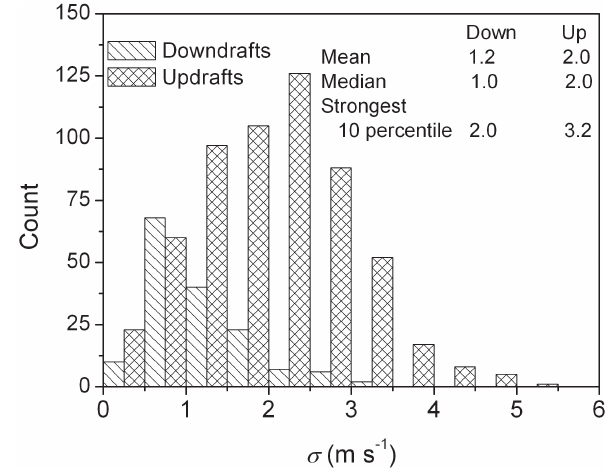
Fig. 6. Distribution for spectral width in fair-weather and convective cores in the tropopause region (16–20km).